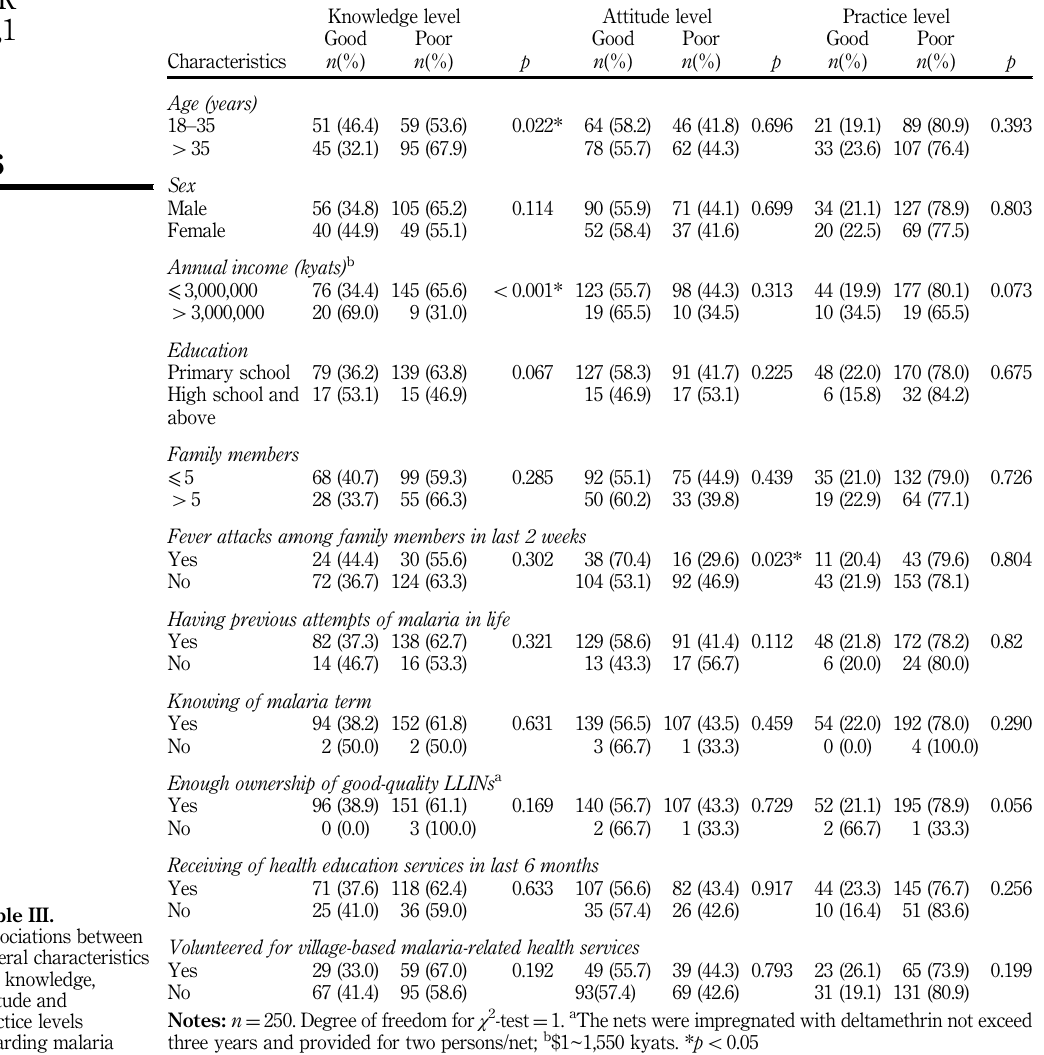
Table III. Associations between general characteristics and knowledge, attitude and practice levels regarding